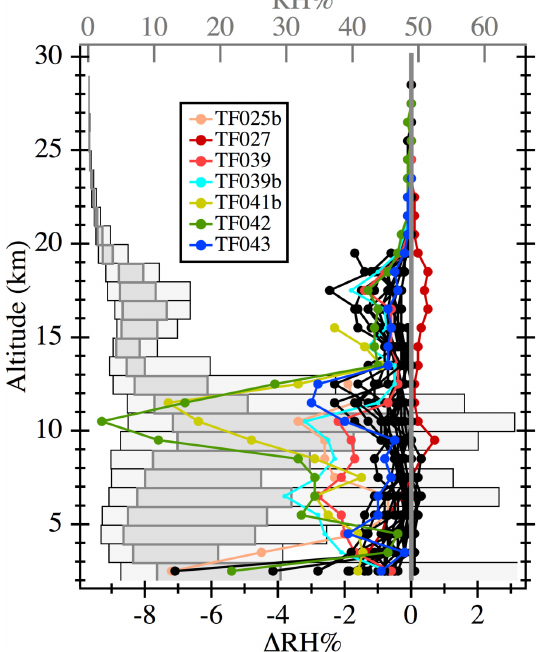
Fig. 11. Profiles of differences between the RH values calculated from frost point hygrometer measurements using independent tem- perature measurements by RS92 sondes (FP RS92 ) and iMet sondes (FP IMET ). Four of the 7 anomalous 1 RH profiles identified here were also anomalous for RS92-iMet 1T (Fig. 2). Similar to Fig. 10, the lighter and darker gray horizontal bars depict the inner-90% and interquartile ranges of FP RS92 RH values, demonstrating the rapid decline of RH above 20km.